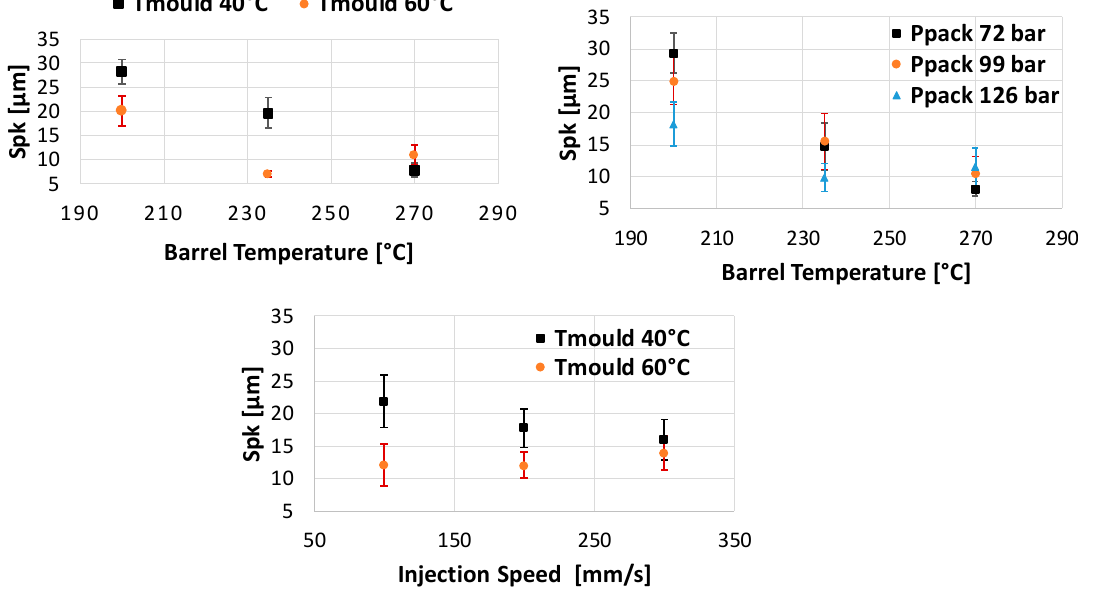
Figure 8. Two factor interactions for Spk: barrel temperature —T b and mould temperature—T m ( top left ); barrel temperature—T b and packing pressure—P p ( top right ); injection speed—V i and mould temperature—T m ( bottom ).